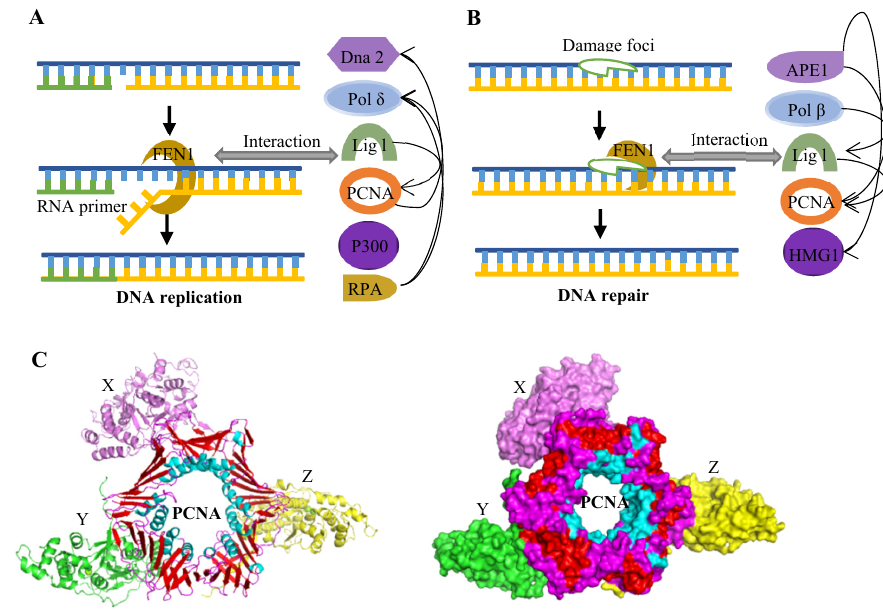
Figure 3. The proteins interact with FEN1. ( A ) Proteins act in concert with FEN1 during DNA replication. ( B ) Proteins act in concert with FEN1 during DNA repair. Arrows indicate stimulation of enzyme activity. ( C ) The structure of the human FEN1-PCNA complex (PDB ID: 1UL1). Three FEN1 molecules are colored in pink (X), green (Y) and yellow (Z), and three sections of PCNA are respectively colored as red, blue and violet.